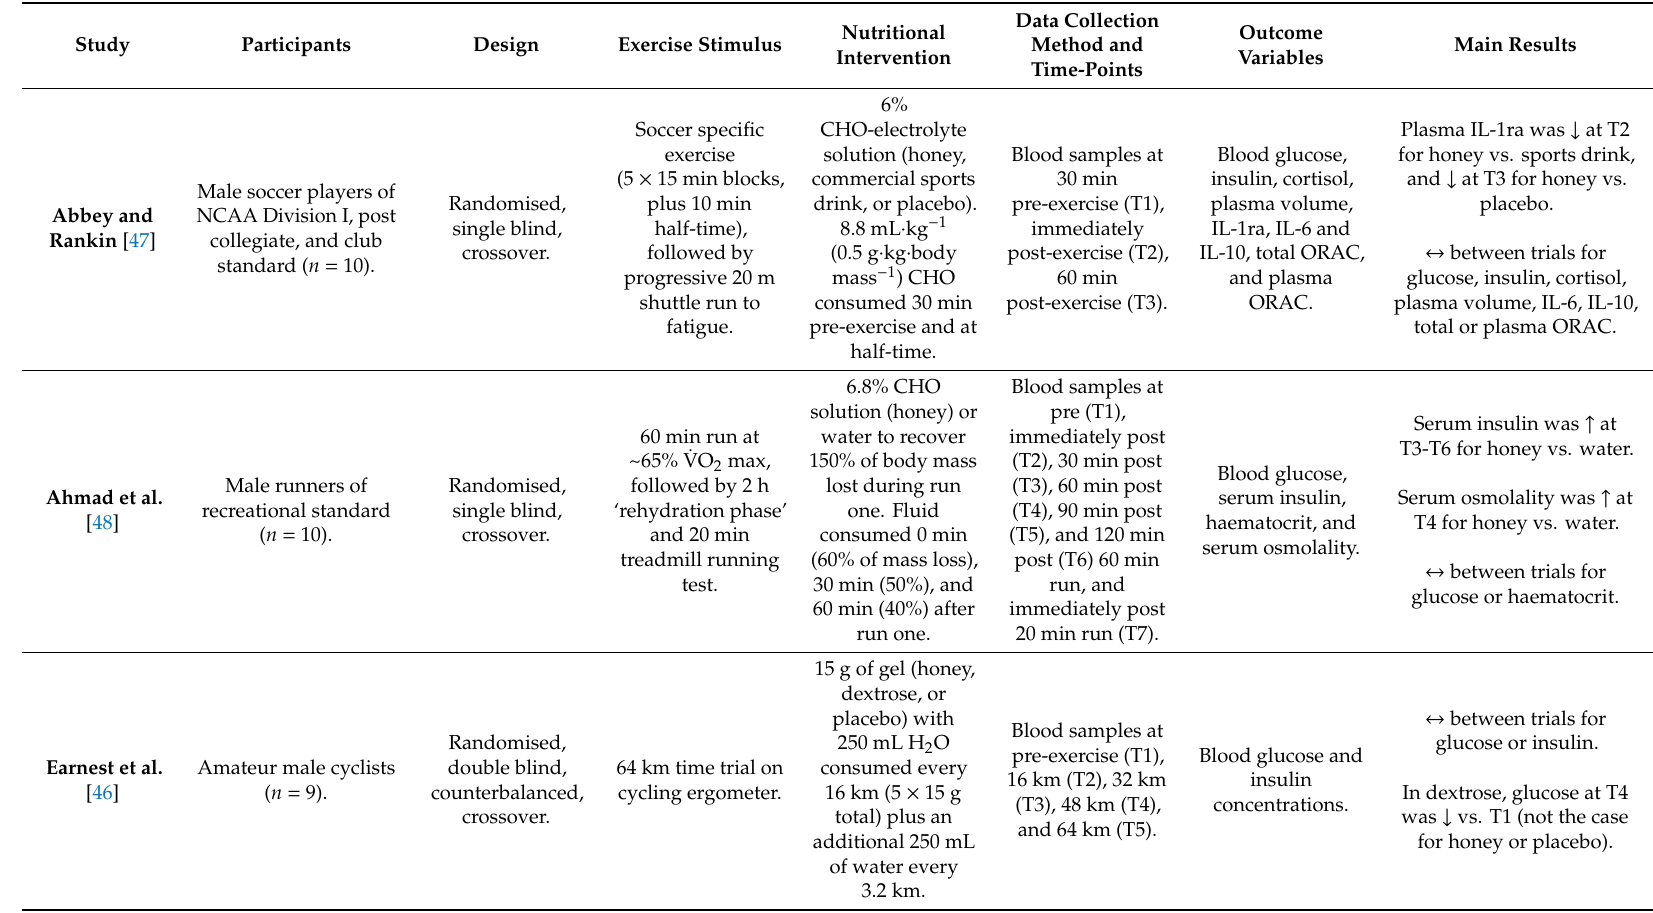
Table 1. Studies examining the e ff ect of acute honey supplementation on biochemical responses to a single exercise